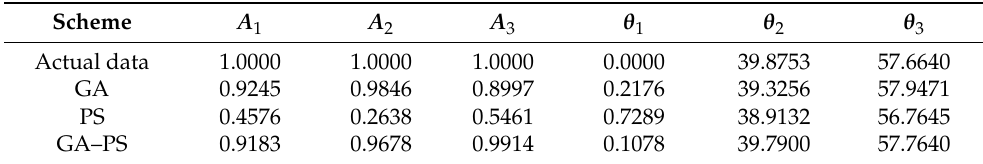
Table 7. Comparison of DOAs achieved using GA, PS, and GA–PS.